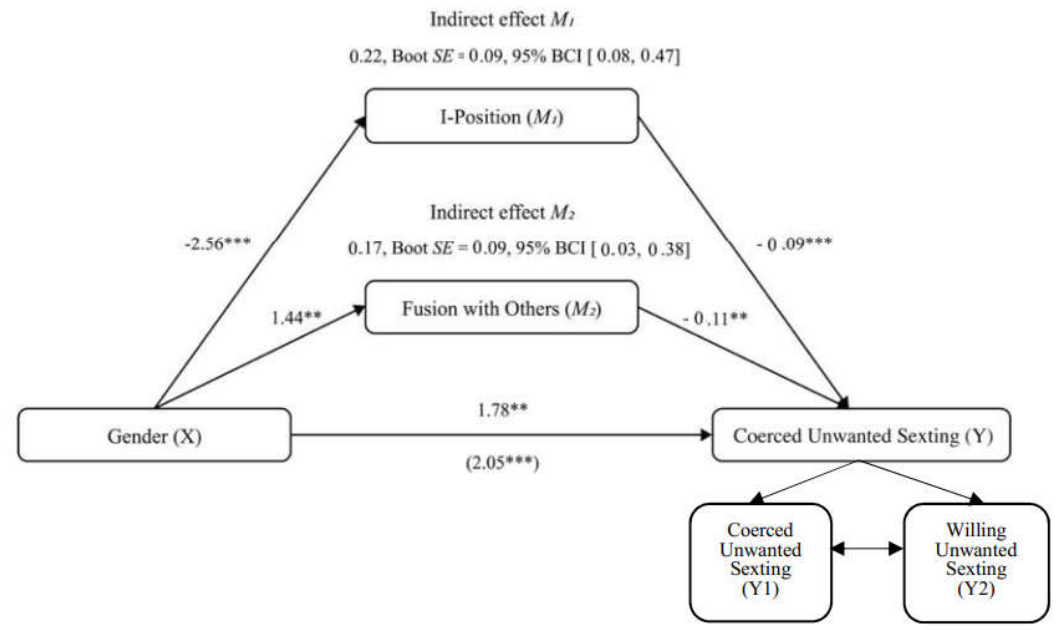
Figure 3. Parallel multiple mediation model testing I-Position and Fusion as mediators of the effects of gender on coerced unwanted sexting. Note: Parallel multiple mediator model for the relationship between gender and coerced unwanted sexting, mediated by I-Position and Fusion (DoS). Total effects in parentheses. All coefficients unstandardized [59] BCI: bias corrected confidence interval; 10,000 bootstrap samples. Gender ( ref = women); Coerced unwanted sexting ( ref = yes). ** p < 0.01, *** p <